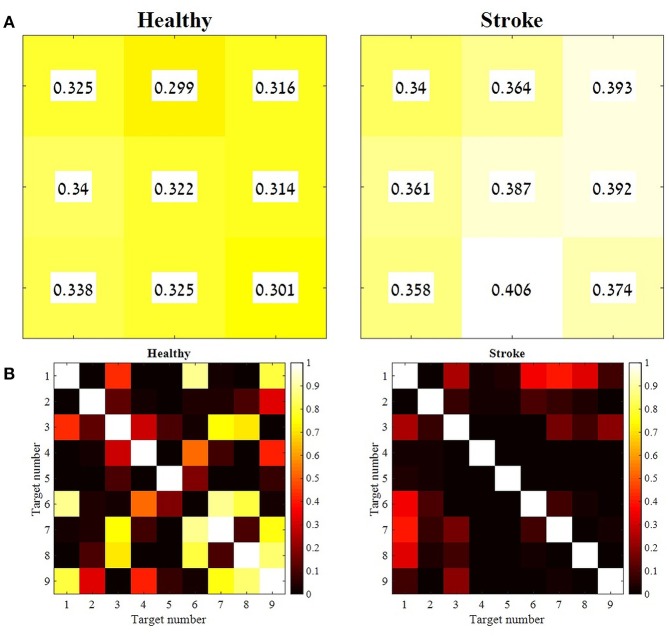
The mean similarity between the representative set of synergies and synergies from all other movement directions, and the level of significance for both groups. For each participant from both groups, synergies were extracted for each movement direction separately. Therefore, each participant represented by nine synergy matrices. The distances between each of the nine synergy matrices and the representative set of synergies were computed and averaged for each group. Each cell in the matrices in (A) correspond to a target as indicated in Figure 1B. A paired sample t-test was applied to test the differences between the similarity values of each combination of the nine target directions, for group separately (B). The mean similarity values in (A) were aligned according to Figure 1B. The similarity index, as indicated in Equation (5) takes values from zero to one, in which zero in complete identity between matrices and one is completely different matrices. Therefore, higher similarity values are indicated by lower values and darker colors, whereas lower similarity values are indicated by higher values and brighter colors. The p-values matrices in (B) indicate consistent significant differences between different movement directions in the study group (consistent dark colors) compared to variable similarity levels between different movement directions in the control group, which is indicated by different brightness of cell between different movement directions.